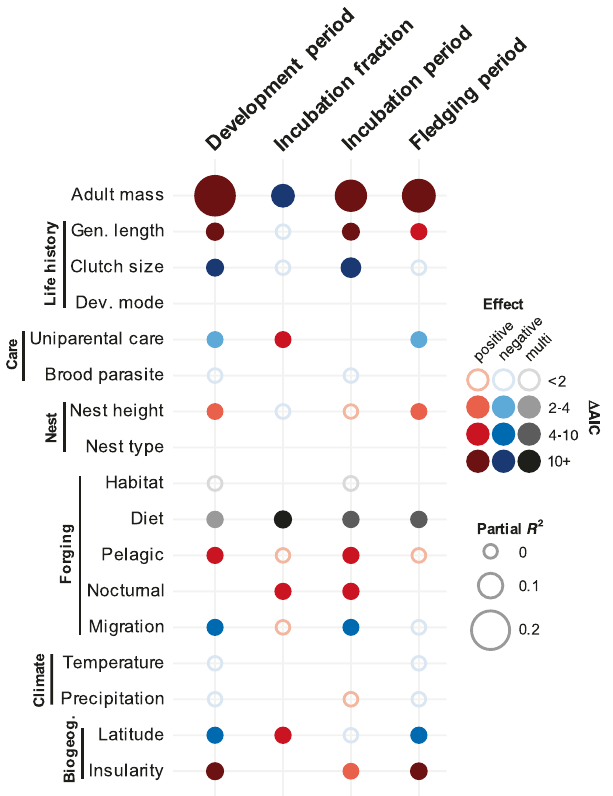
Fig. 3 Predictors of the duration and partitioning of developmental period lengths in birds. Phylogenetically controlled multi-predictor models of development period, incubation fraction, incubation period and fl edging period. Un fi lled circles indicate factors that were signi fi cant as single predictors but not signi fi cant in a multi-predictor model. Gaps indicate factors that were not signi fi cant ( Δ AIC < 2) as single predictors and were therefore not included in the multi-predictor model. Red and blue points indicate predictors with positive and negative effects, respectively. Predictors with grey points (e.g., Diet) represent categorical variables with >2 ( ‘ multi ’ ) levels. Δ AIC values indicate the change in model support when the focal predictor was dropped from the model, with larger Δ AIC values indicating greater support for the importance of a predictor. Sample sizes (number of species) for the models were 1665, 1685, 1935 and 1665 for development period, incubation fraction, incubation period and fl edging